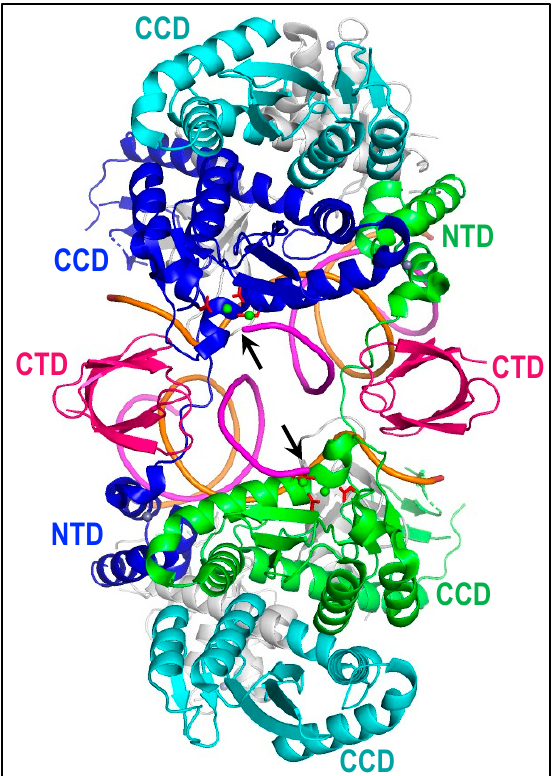
Figure 3. HIV-1 intasome structure (protein database (PDB) accession code 6PUT). Cyan-blue (top) and green-cyan (bottom) IN dimers interact via the CCD-CCD dimerization interface. The internal blue-green IN dimer is bound to vDNA, which is colored orange and magenta to highlight non- transferred and transferred DNA strands, respectively. The 3 ′ ends of the magenta transferred strands, which are indicated by arrows, are engaged by inner IN dimer DDE active sites (red sticks in association with two calcium ions, which are shown as green spheres). NTD-associated grey spheres are zinc. Synaptic CTDs are in hotpink to indicate their origin from peripheral IN tetramers, which were otherwise omitted from the atomic model. Gray is used to deemphasize secondary structural elements that do not directly contribute to the CIC.